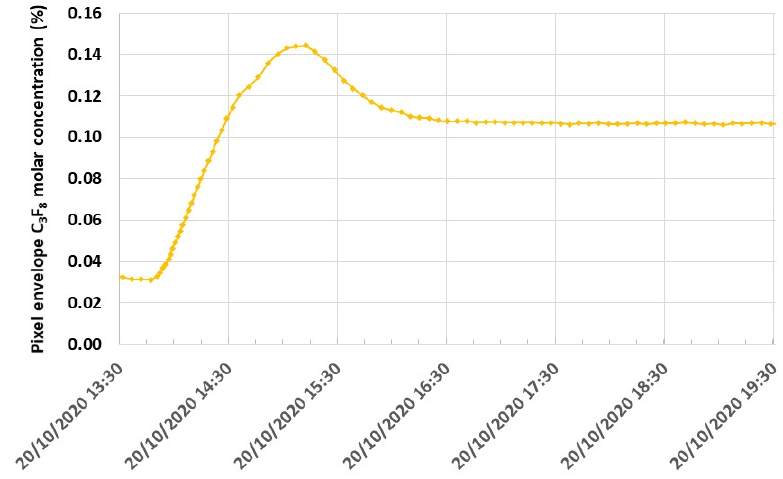
Figure 11. Variation of C 3 F 8 concentration seen in N 2 -purged environmental volume surrounding the ATLAS ‘pixel’ silicon tracker sub-detector during a global restart of its C 3 F 8 evaporative cooling